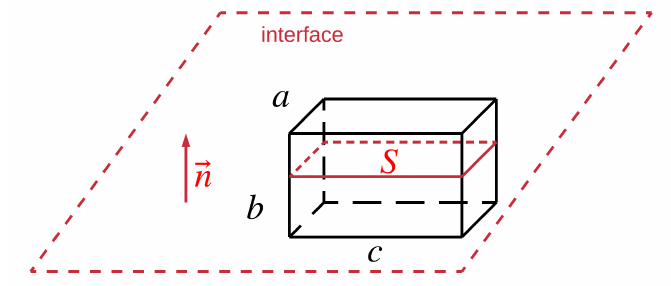
Figure 1. A cuboid is cut by an interface (red dotted surface), and their common surface has an area of S . The interface, with (cid:126) n being its unit normal vector, is perpendicular to four inter-parallel